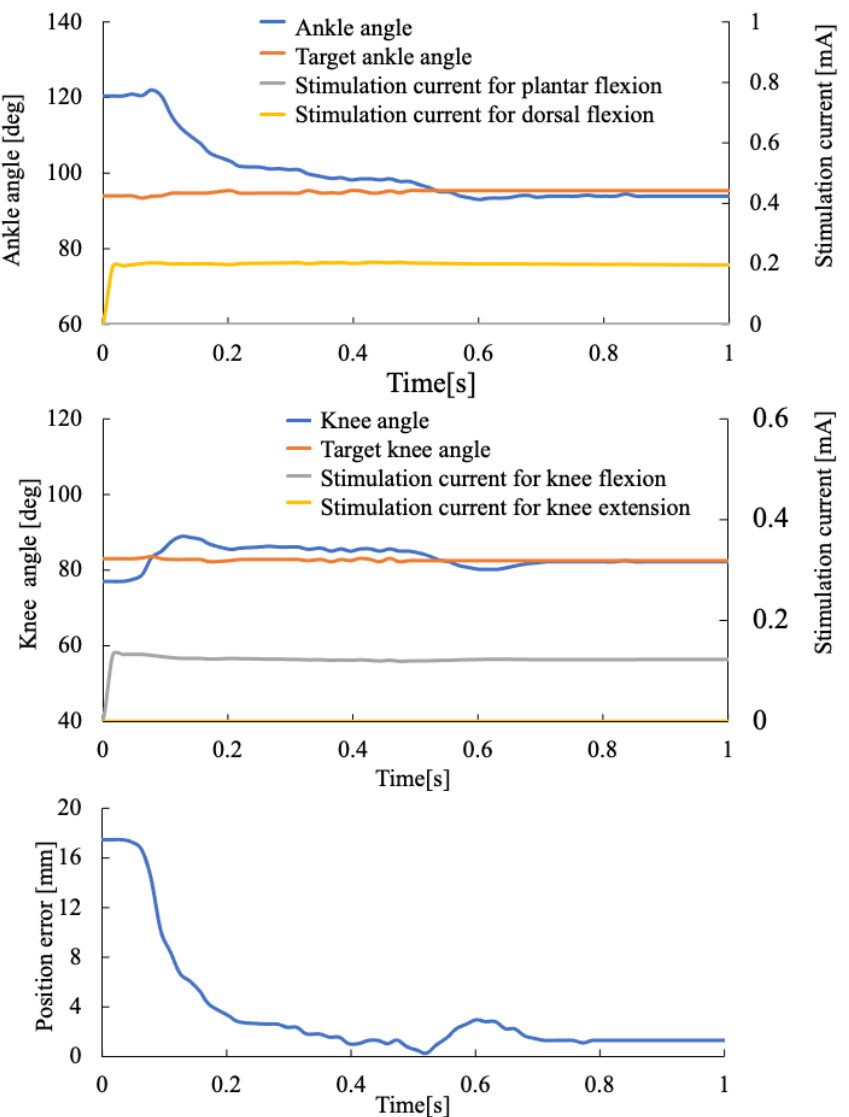
Figure 9. Step response of rat ankle and knee joints when the feedback + feed-forward control was used to move the toe to the target position. The lowest graph indicates the position error of the rat toe during the